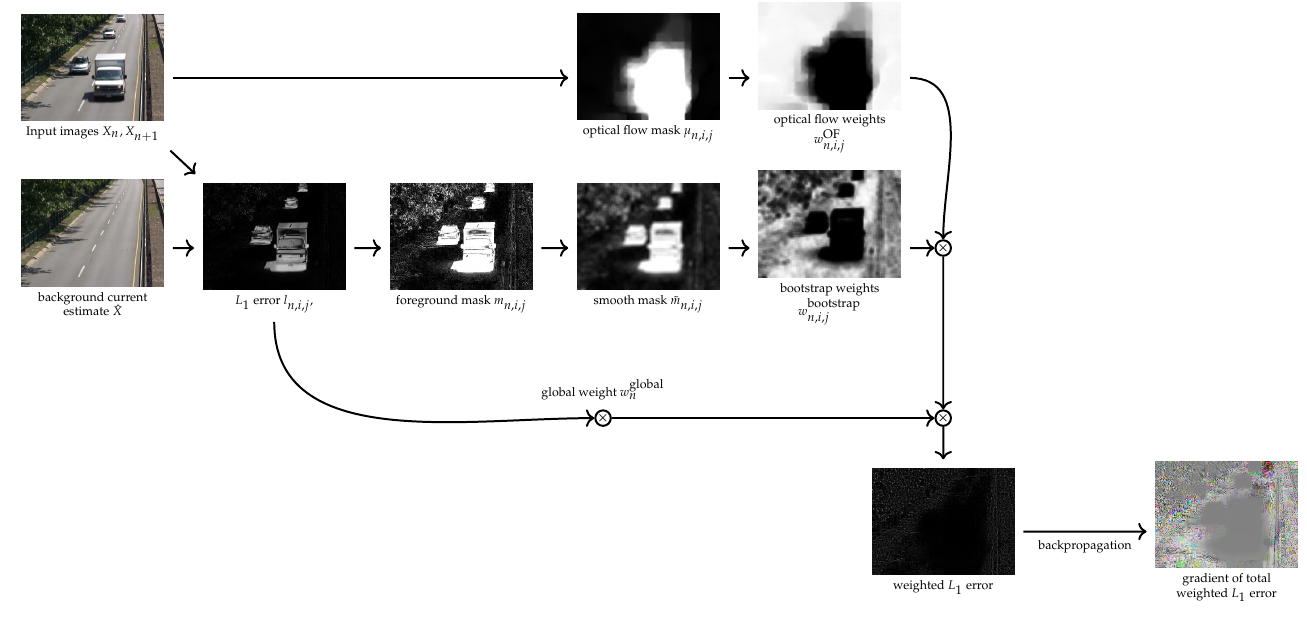
Figure 1. Schematic of loss function and gradient computation (Images are normalized in the range